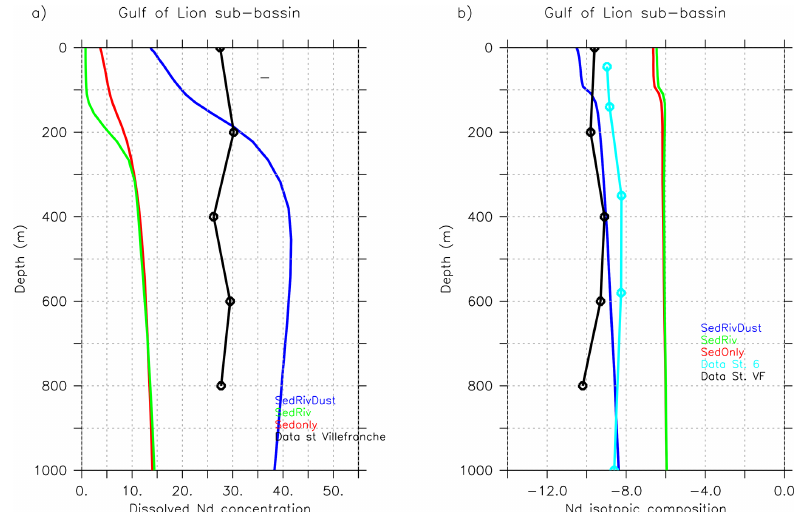
Figure A6. Comparison of the vertical profiles between in situ data (from Henry et al. (1994)) and model output for (a) [Nd] (in pmolkg − 1 ) and ε Nd in (b)